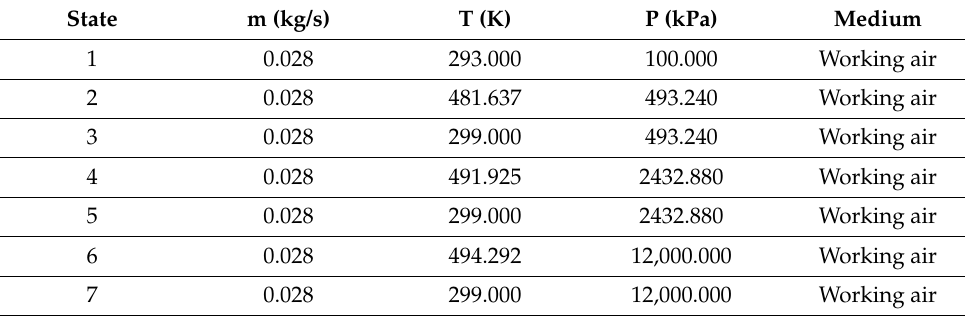
Table 2. Simulation parameters of the LAES system with pressurized air (5